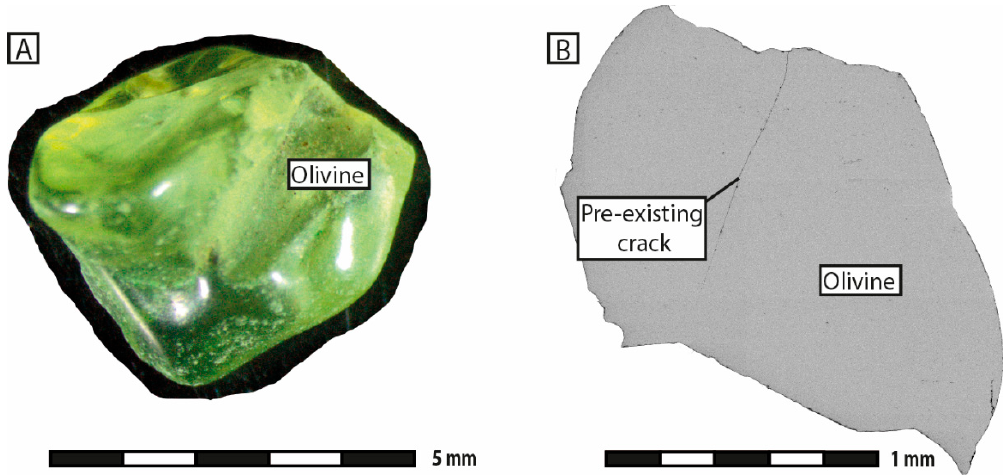
Figure 1. ( A ) Optical micrograph and ( B ) Backscattered electrons (BSE) image of an olivine grain before starting the experiments.